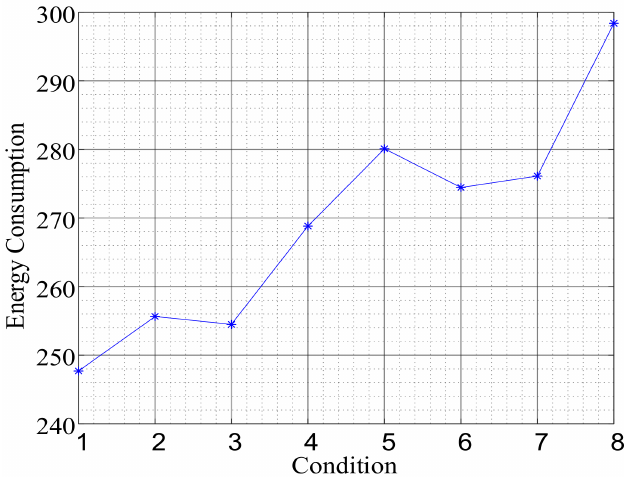
Figure 21. Overall energy variation depending on relay location in different